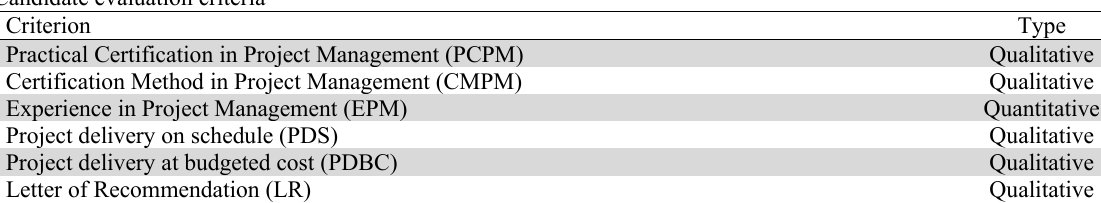
Fig. 2. Framework for the combined application of TODIM-FSE and Behavioral TOPSIS Candidate evaluation